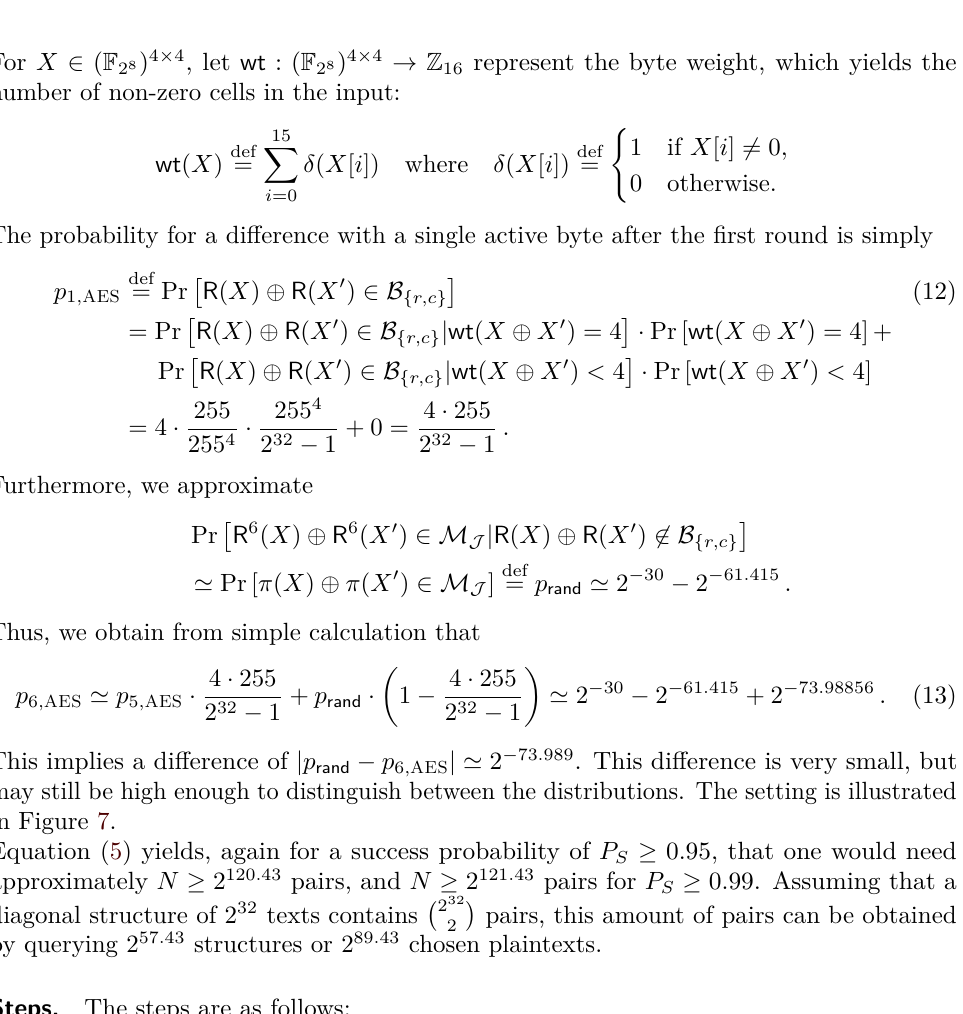
Figure 7: Six-round distinguisher. Darkened cells represent bytes with active (non-zero) difference, white cells represent bytes with zero